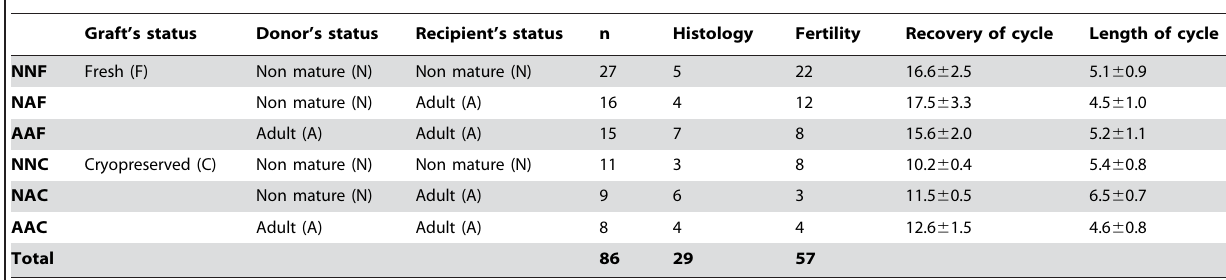
Table 1. Groups of transplanted mice and cyclic hormonal activity.